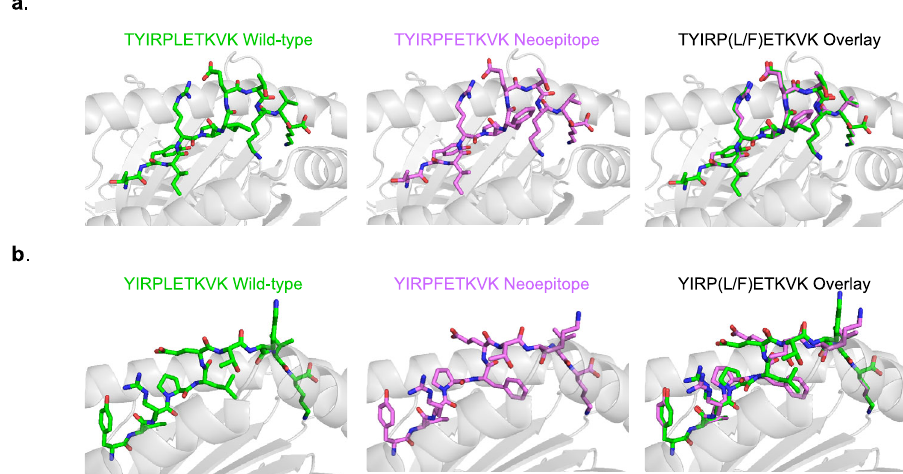
Fig. 4 Models of peptide/MHC I complexes indicate structural and physical correlates with immunogenicity. a For the tumor rejecting TYIRPFETKVK neoepitope, the leucine-to-phenylalanine substitution at position 6 is predicted to increase hydrophobic solvent accessibility by 17 Å 2 , with the aromatic phenylalanine ring partially exposed for interactions with T cell receptors. An overlay of the neoepitope and its wild type counterpart demonstrates the substantial differences between the wild type peptide and neoepitope. b For the tumor rejecting YIRPFETKVK neoepitope, with the leucine-to- phenylalanine substitution now at position 5, the modeling predicts structural alterations in exposed side chains in response to the mutation, as well as a reduction in exposed hydrophobic solvent accessible surface area of 23 Å 2